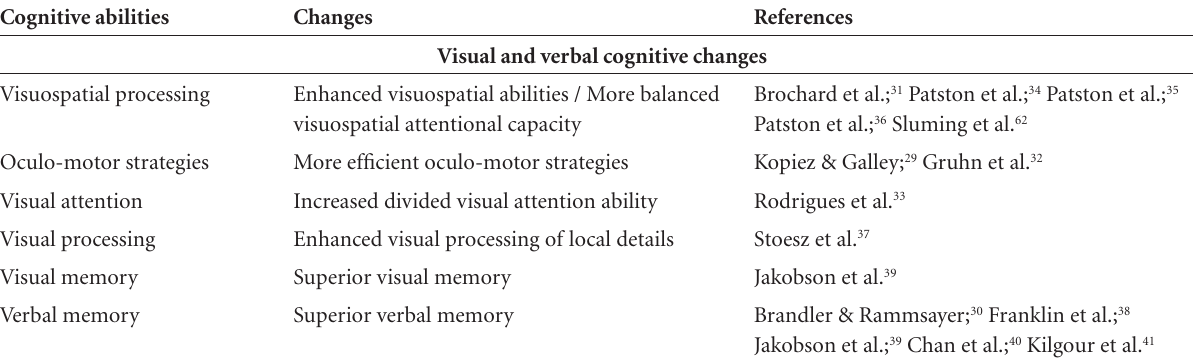
Table 2. Some visual and verbal cognitive changes identified in musicians and adults with music training. Cognitive